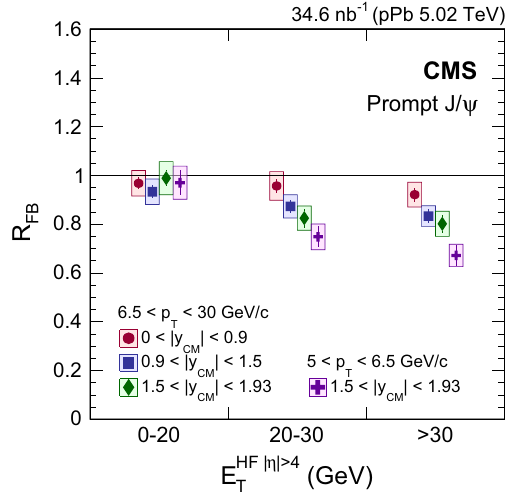
Fig. 7 Dependence of R FB for prompt J /ψ mesons on the hadronic activity in the event, given by the transverse energy deposited in the CMS detector at large pseudorapidities E HF slightly shifted horizontally so that they do not overlap. The vertical bars represent the statistical uncertainties and the shaded boxes show the systematic